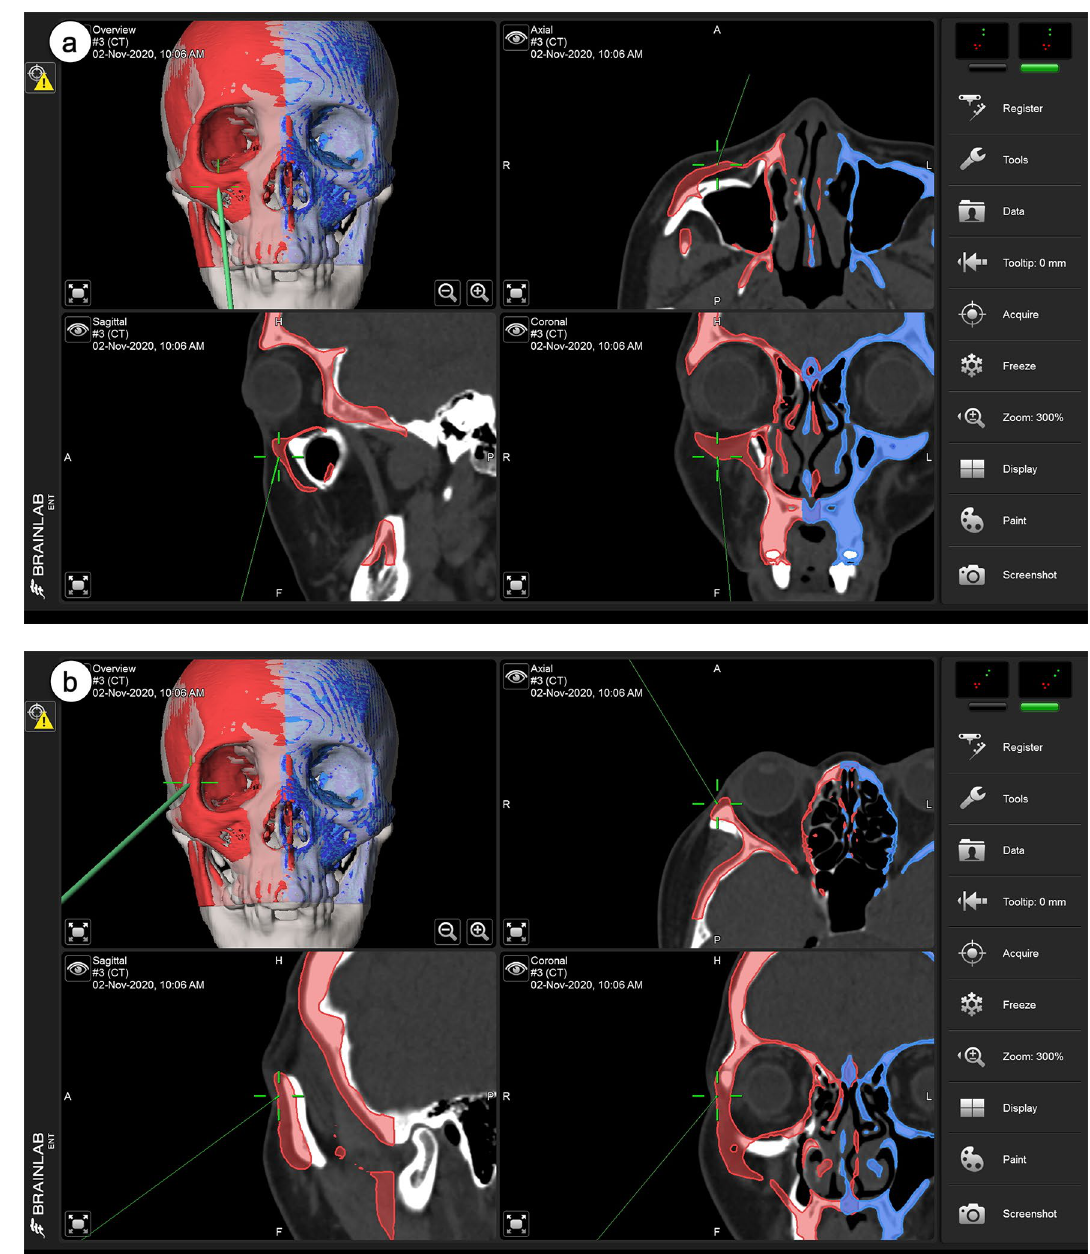
Figure 1. ( a ) Intraoperative real-time navigation for confirmation of zygomatic bone position at the zygomatic prominence. The semiautomated segmentation objects of the digital template were created on the unaffected side (blue) and superimposed onto the preoperative CT images, then they were mirrored to the affected side (red), resulting in an ideal presurgical plan with symmetrical positioning of the bones. The real-time position of the reduced zygoma prominence was confirmed by the laser pointer in the axial, coronal, and sagittal views. CT, computed tomography. ( b ) Intraoperative real-time navigation for confirmation of zygomatic bone position near the zygomaticofrontal junction. The real-time position of the reduced zygoma near the zygomaticofrontal junction was confirmed by the laser pointer in the axial, coronal, and sagittal views. ( c ) Intraoperative real-time navigation for confirmation of reconstructed implant position on the orbital floor. The real-time position of the reconstructed implant is shown, as verified on the orbital floor by the laser pointer in the axial, coronal, and sagittal